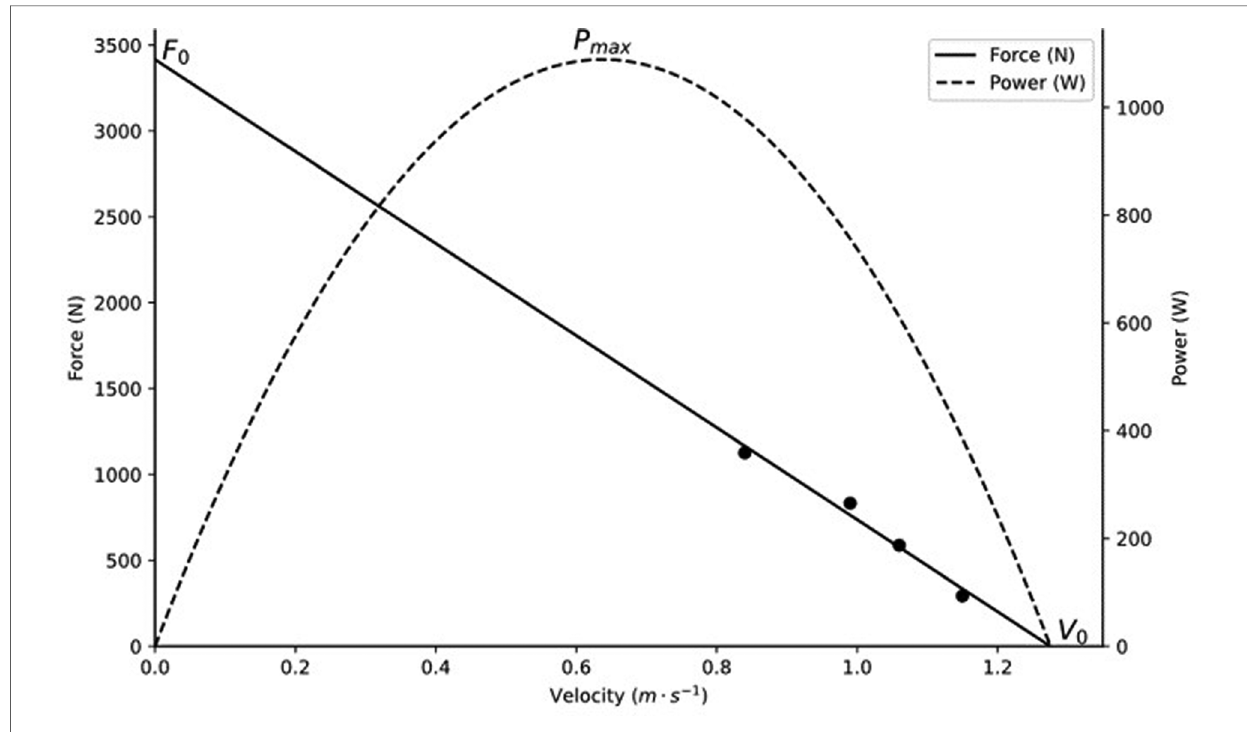
FIGURE 3 Example force-velocity pro fi le.